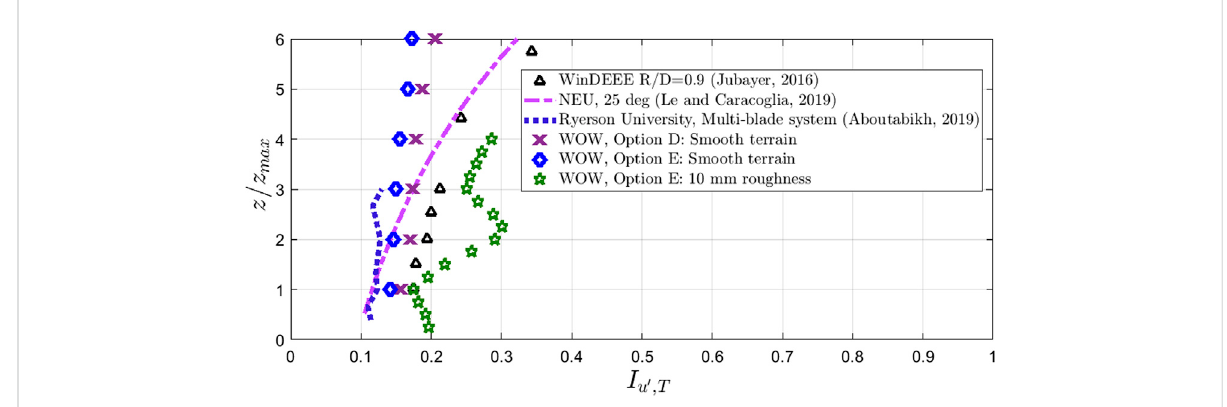
FIGURE 11 Turbulence intensity vertical pro fi les for downburst simulator Options D and E at the TTC for smooth terrain and 10-mm thick surface